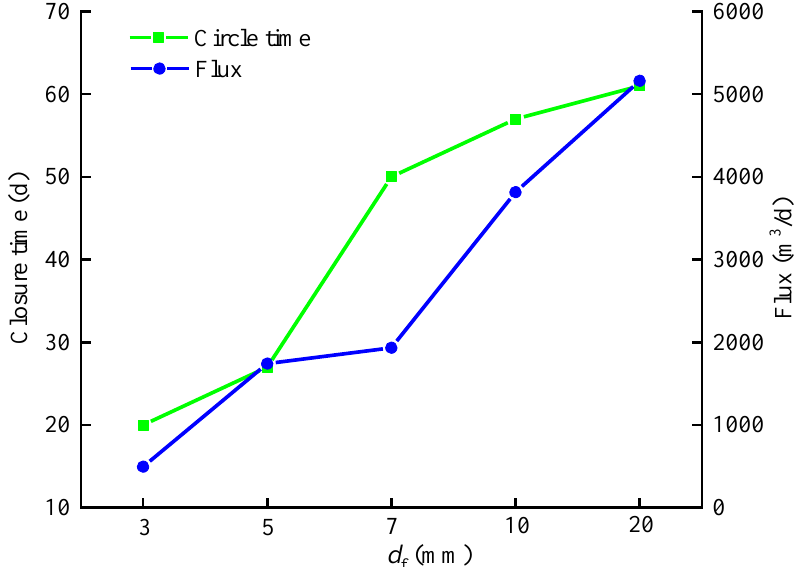
Figure 17. The relationship between the closure time of the frozen wall and the water flux in fracture.